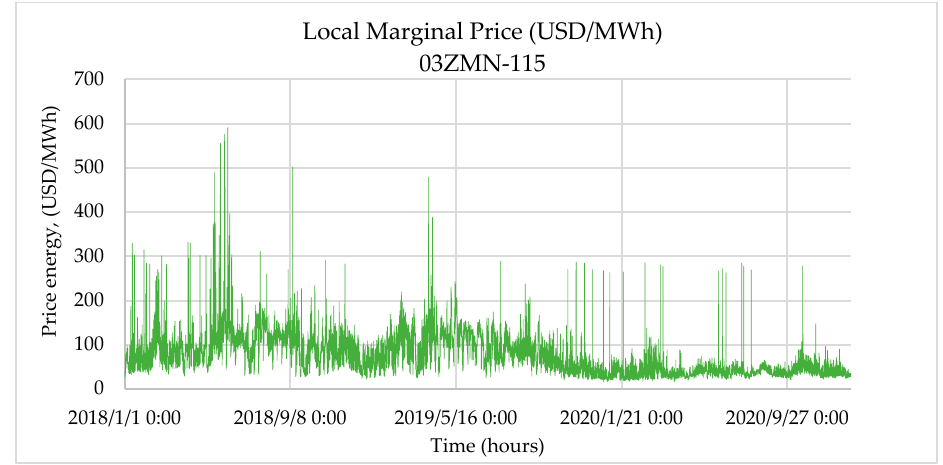
Figure 8. Behavior of the price of energy period 2018–2020 . Own source with CENACE information, 2020.